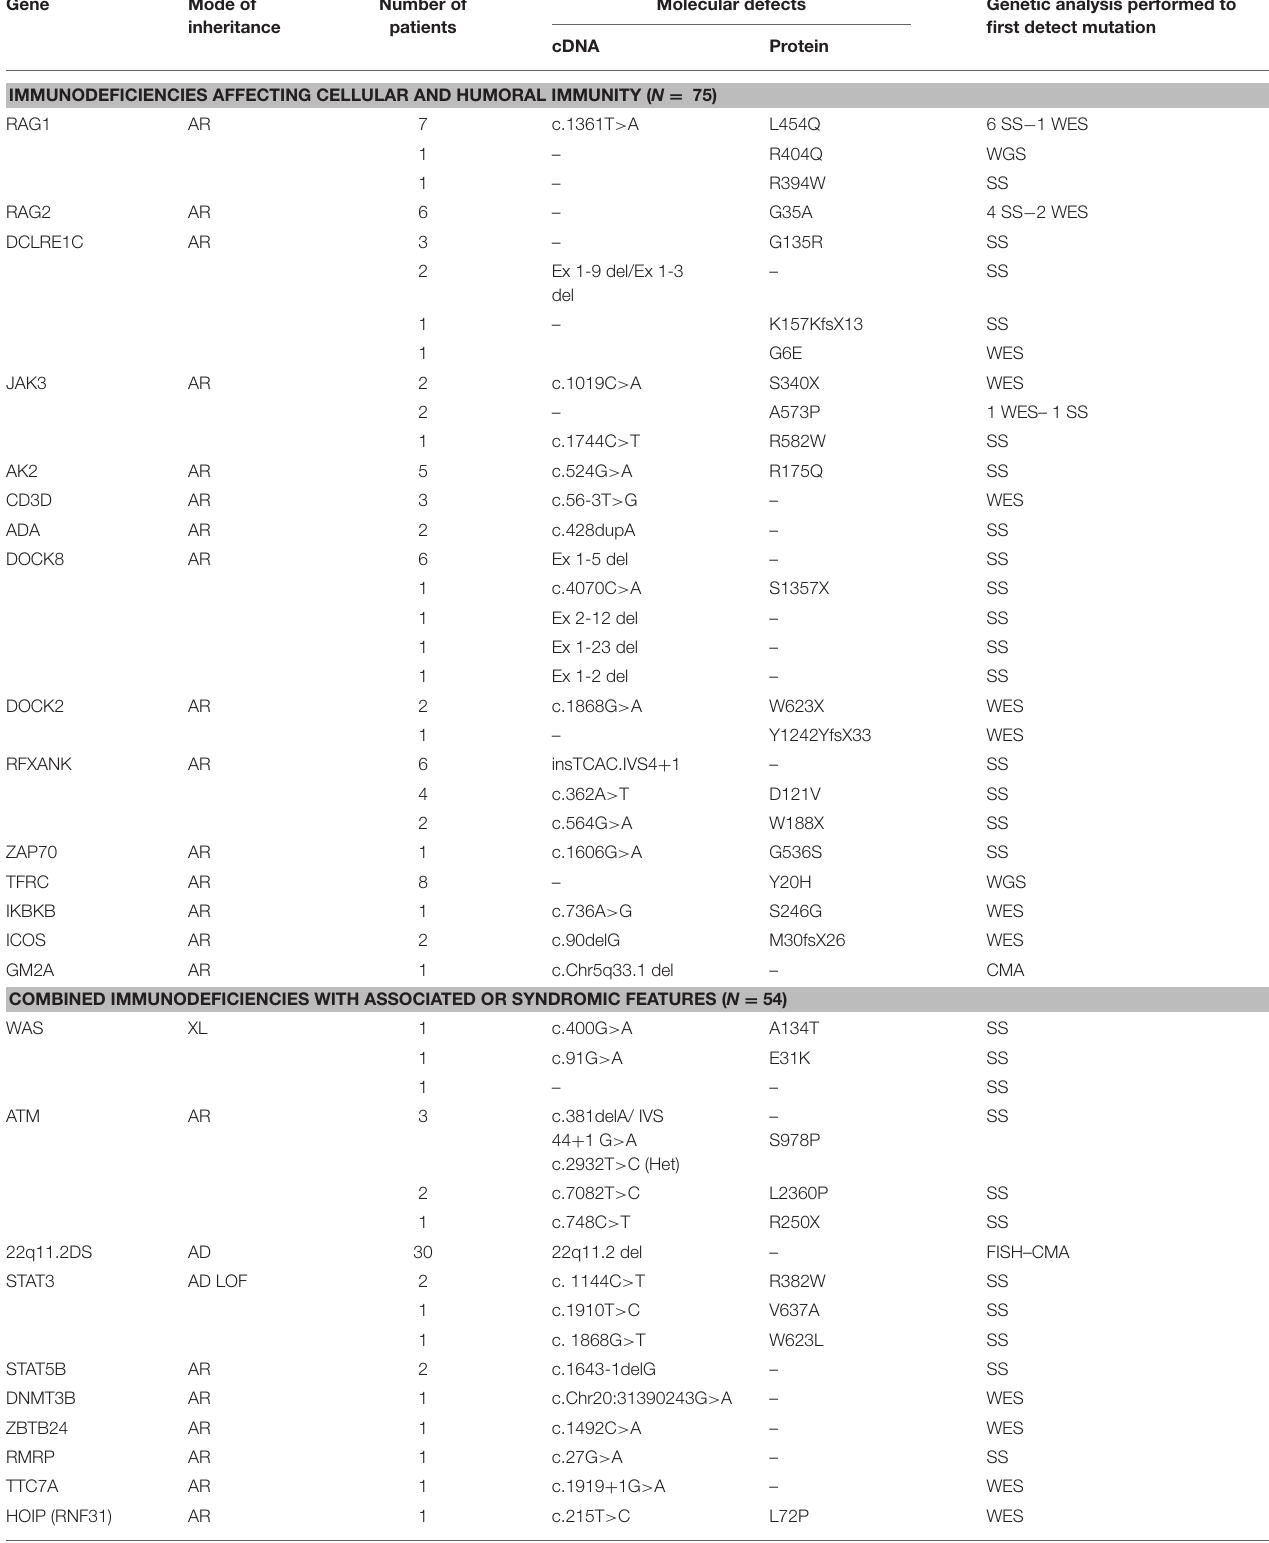
Molecular defects Genetic analysis performed to